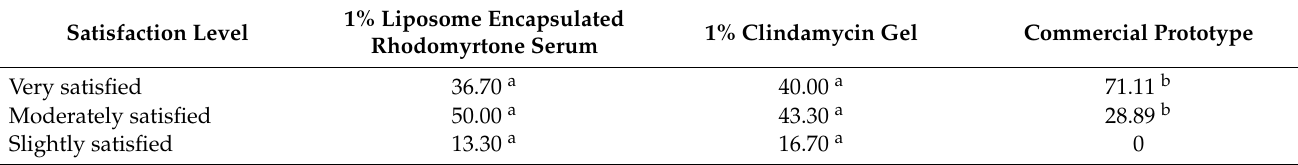
Table 3. Percentage of volunteers’ responses to